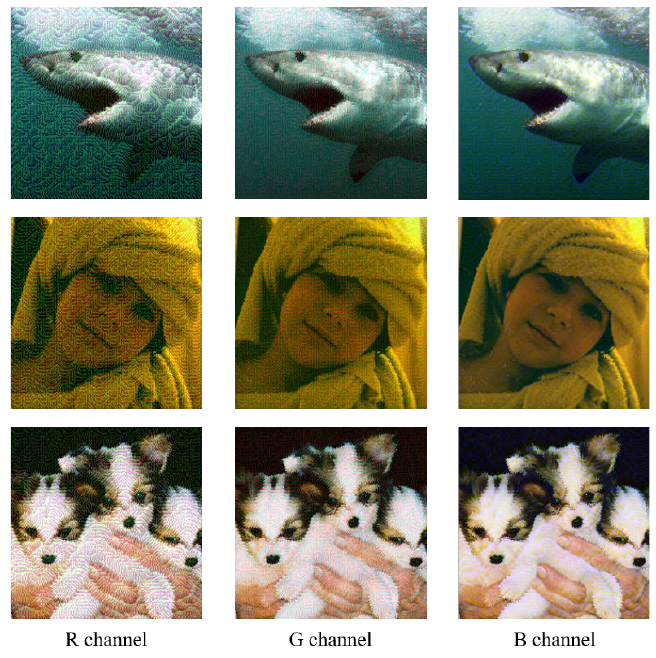
Figure 3. Visual comparisons corresponding to R , G and B